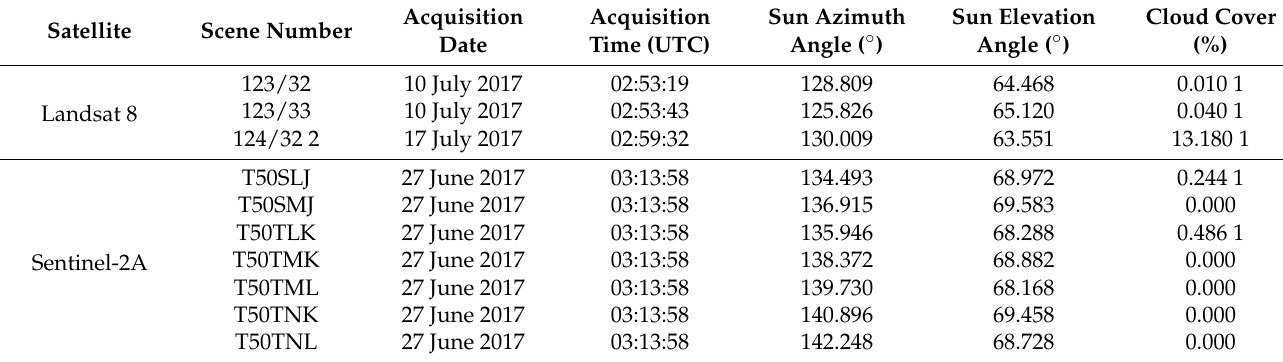
Table 2. Information on the selected Landsat 8 and Sentinel-2A